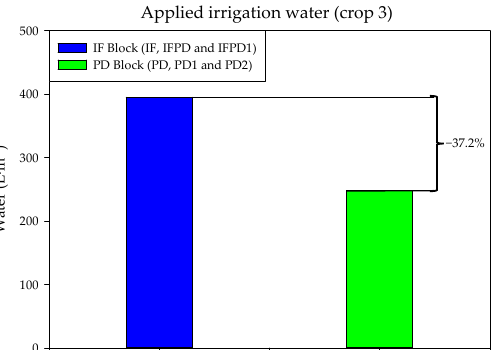
Figure 4. Irrigation water applied in the IF and PD blocks during the third cycle of tomato cultiva- tion. Inorganic fertilization (IF); inorganic fertilization + 3.5 kg · m − 2 of tomato plant debris (IFPD); inorganic fertilization + 5 kg · m − 2 of tomato plant debris (IFPD1); 3.5 kg · m − 2 of tomato plant debris (PD); 5 kg · m − 2 of tomato plant debris (PD1); 6.5 kg · m − 2 of tomato plant debris